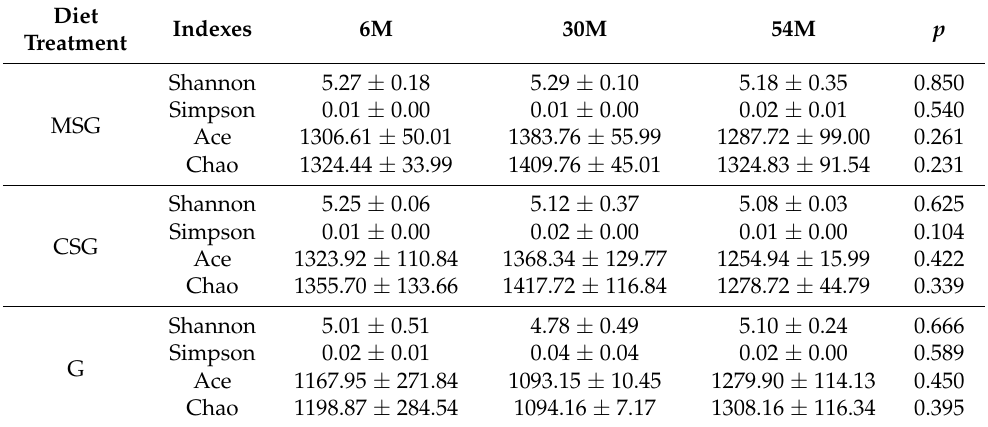
Table 9. Alpha diversity results of rumen microflora in Tianzhu white yaks of different ages.